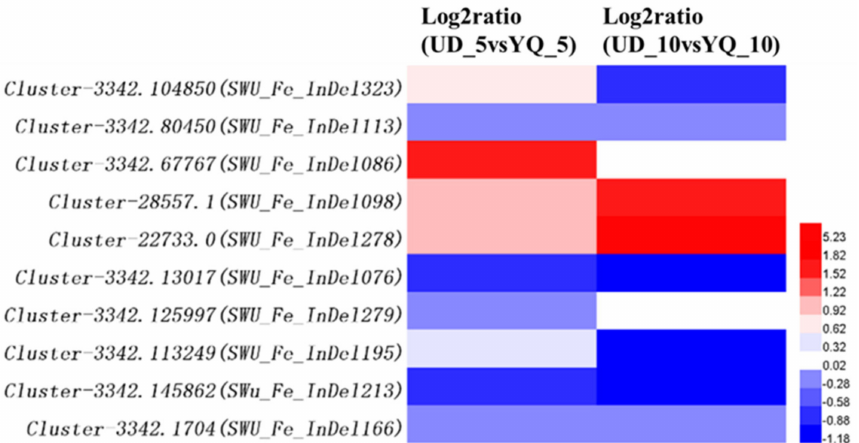
Figure 5. Expression analysis of candidate genes corresponding to nearest markers located in QTL